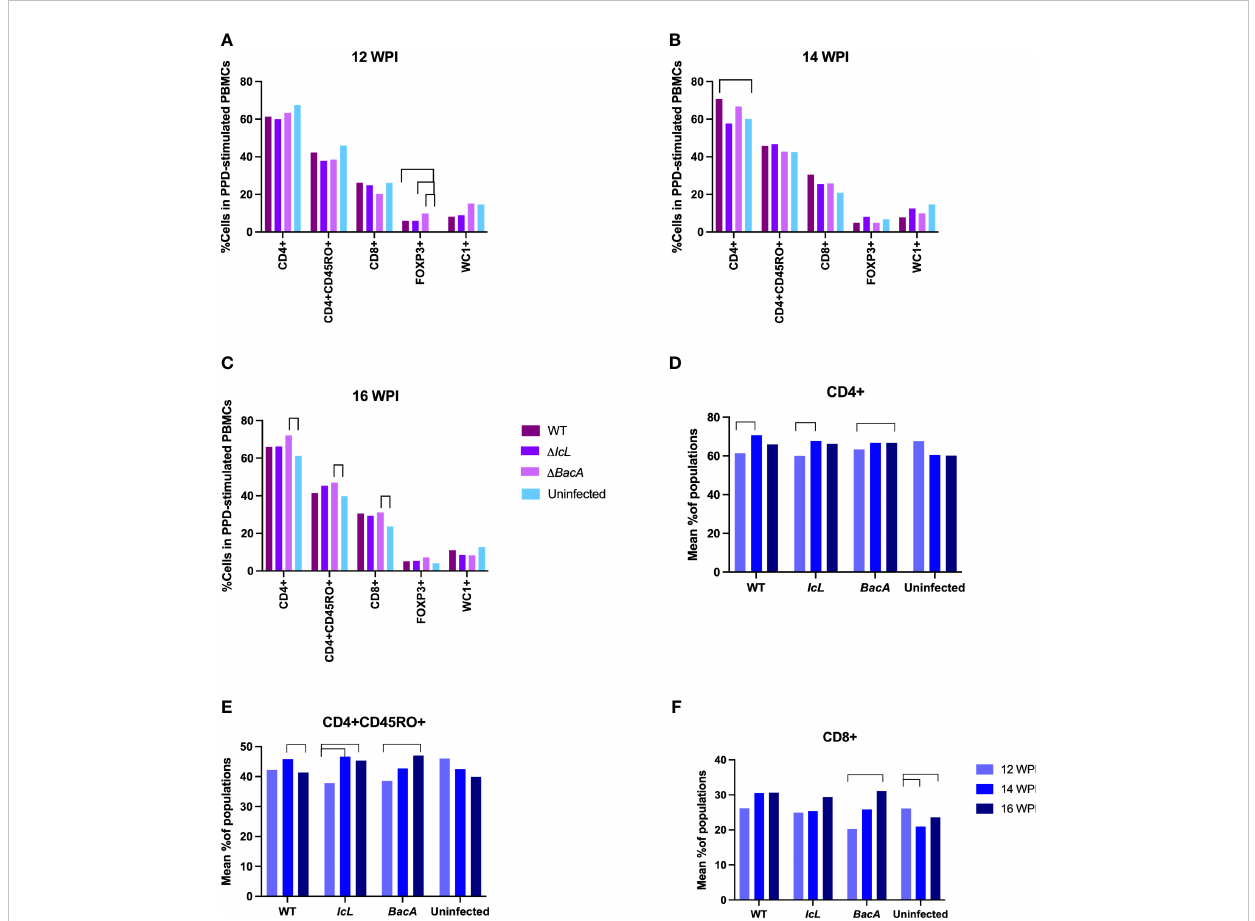
FIGURE 5 (A-C) Lymphocyte proliferation after stimulation of PBMCs with PPDa for 24 hours. PBMCs were isolated from all mutants and control groups at 12-, 14-, and 16- weeks post-inoculation and they were stimulated with MAP antigen for 24 hours. Flow cytometry was employed to evaluate populations of proliferated immune cells. The difference among groups were assessed by one-way ANOVA and then further validated by Tukey- Kramer test. (D-F) Changes in cell populations within a group over time. The difference between timepoints were evaluated by one-way ANOVA followed by Tukey-Kramer test. Signi fi cant difference between groups (P value> 0.05) is indicated by lines above